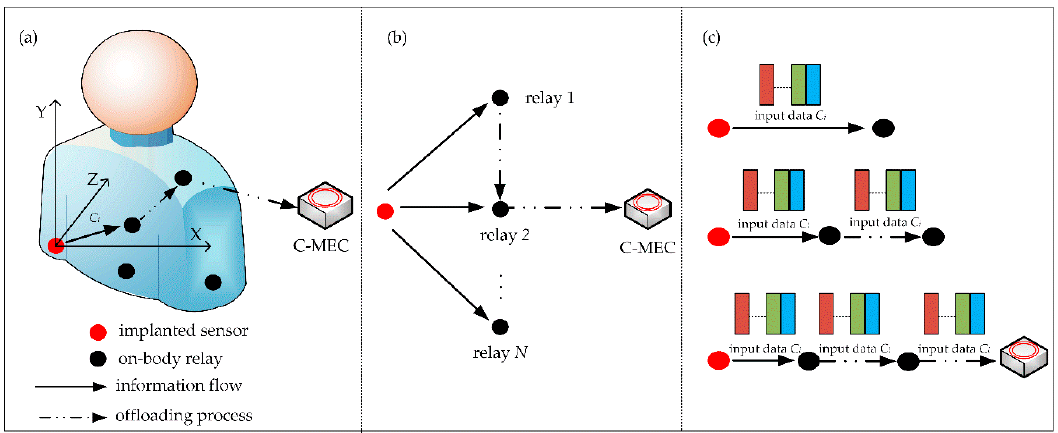
Figure 1. The architecture of the proposed system: ( a ) communication flow; ( b ) information broadcasting; ( c ) task offloading schemes.